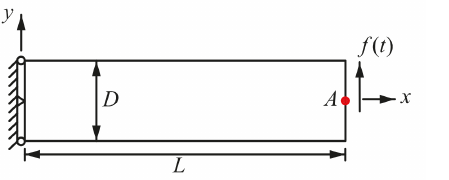
Figure 20. A 2D cantilever beam subjected to a harmonic loading on the right end.